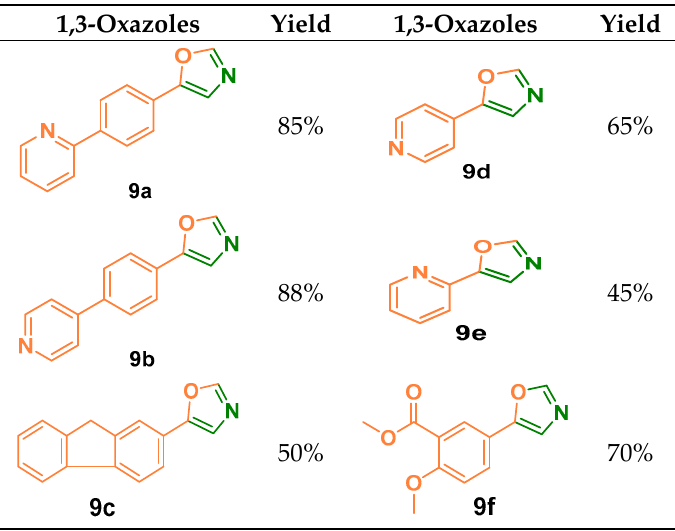
Table 1. 1,3-oxazoles synthetized via Van Leusen reaction under a reactor